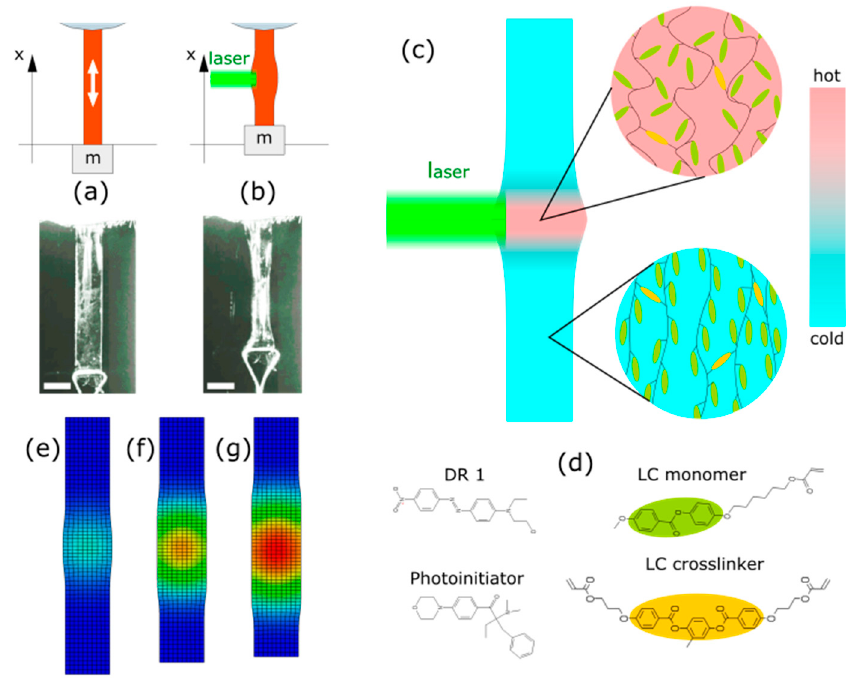
Figure 1. Linear light-driven actuator made of liquid crystal elastomer (LCE) film. A strip cut from an LCE film with nematic orientation is suspended with a weight at the lower end. When illuminated with a laser beam, it contracts along the orientation of the director (shown with the white arrow) due to photo-mechanical effect in the elastomer–schematic and photographs of the experimental setup with the relaxed (light off) ( a ) and actuated (light on) ( b ) strip. The visible narrowing of the central part of the strip in the photographs is due to curling caused by the residual stress in the LCE film. Absorbed light energy locally increases the elastomer temperature and the order ⇆ disorder transition occurs, resulting in a macroscopic deformation (contraction) (c) . Molecules used in the LCE composition: liquid crystal monomer, crosslinker, photoinitiator triggering the polymerization upon UV light absorption and the red dye (Disperse Red 1) ( d ). The colors in the molecular structures correspond to these in ( c ). Snapshots from the finite element method numerical simulations of the LCE actuator deforming upon illumination with a Gaussian laser beam ( e – g ) . The colors scale indicates the elastomer temperature. The white scale bars on the photographs are 2 mm long.